Question: What style of plot is this figure drawn as?
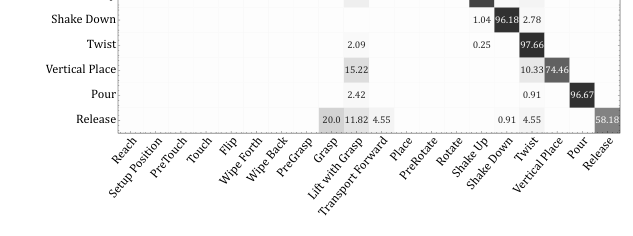
Answer: heatmap